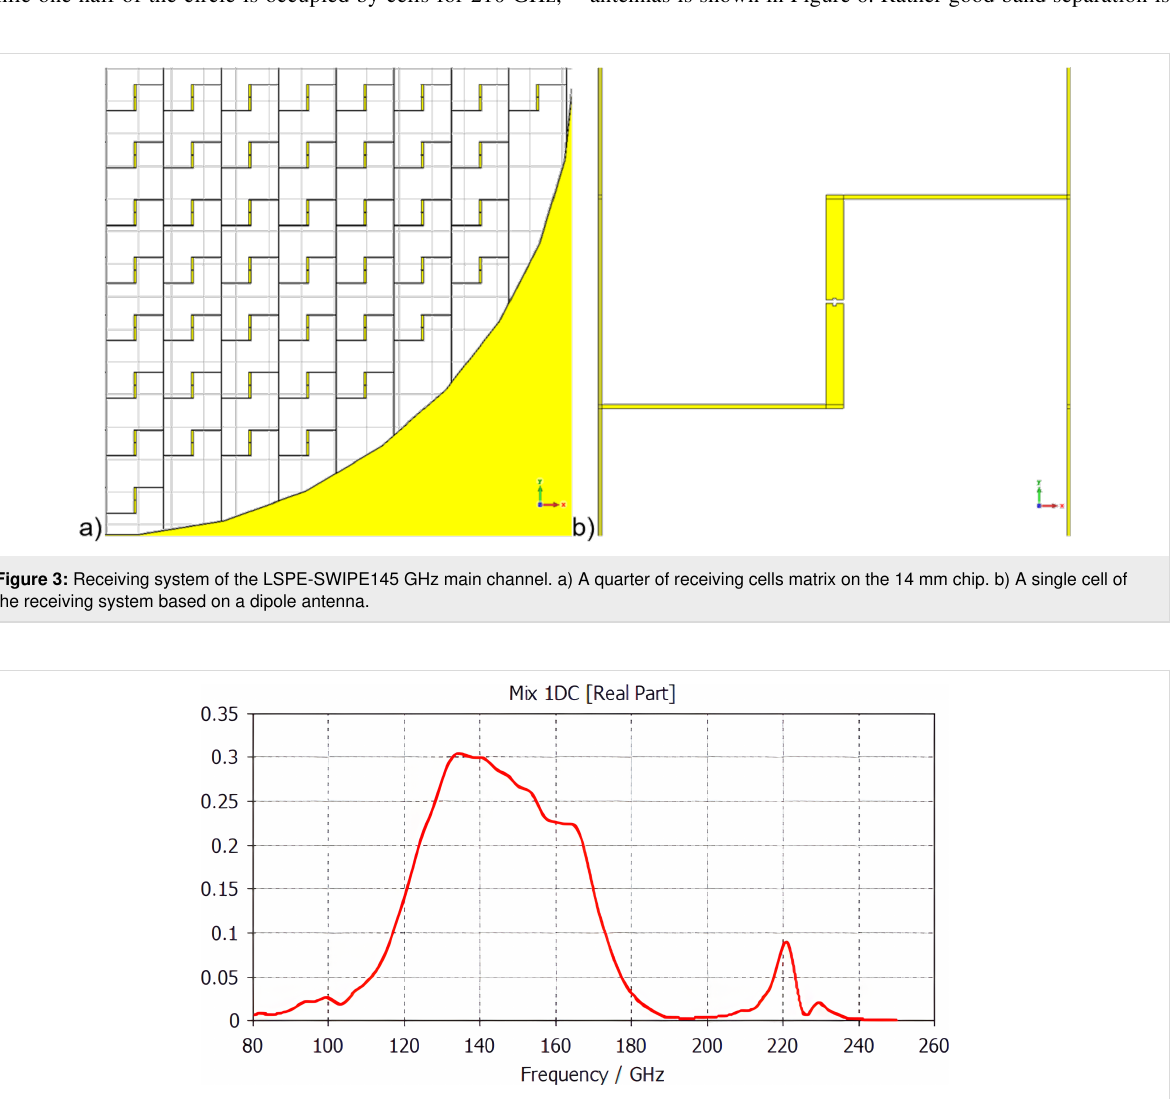
Figure 4: Frequency response of the LSPE-SWIPE 145 GHz main frequency